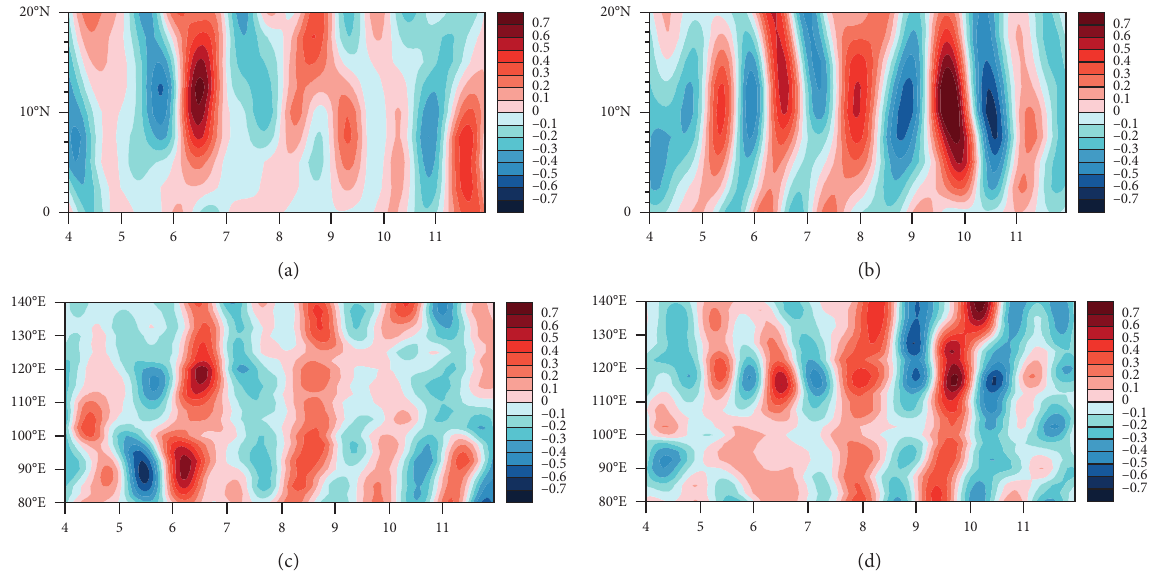
Figure 12: Latitude-time (left) and longitude-time (right) diagram of the daily SCSSM ISO propagation from April to November between ((a) and (c)) late-onset years of the period of 1979–1993 and ((b) and (d)) early-onset years of the period of